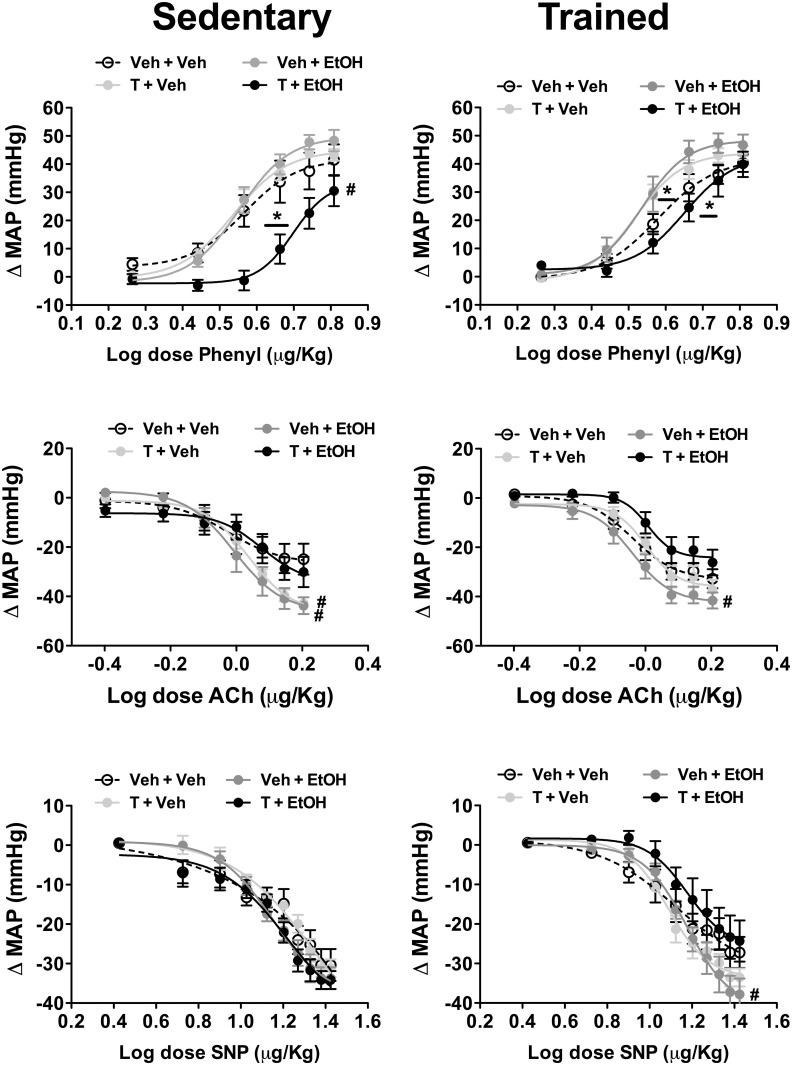
Mean arterial pressure change (ΔMAP) evoked by increasing concentrations of phenylephrine (Phenyl, top), acetylcholine (Ach, middle), and sodium nitroprusside (SNP, bottom) in in animals sedentary and subjected to exercise training on the treadmill (trained) treated with ethanol (EtOH) and/or testosterone (T).The circles represent the mean±SEM. *P<0.05 vs respective Veh + Veh group within same condition for ED50, # P<0.05 vs respective Veh + Veh group within same condition for Emax. Nonlinear regression analysis. (n = 8-9/group).